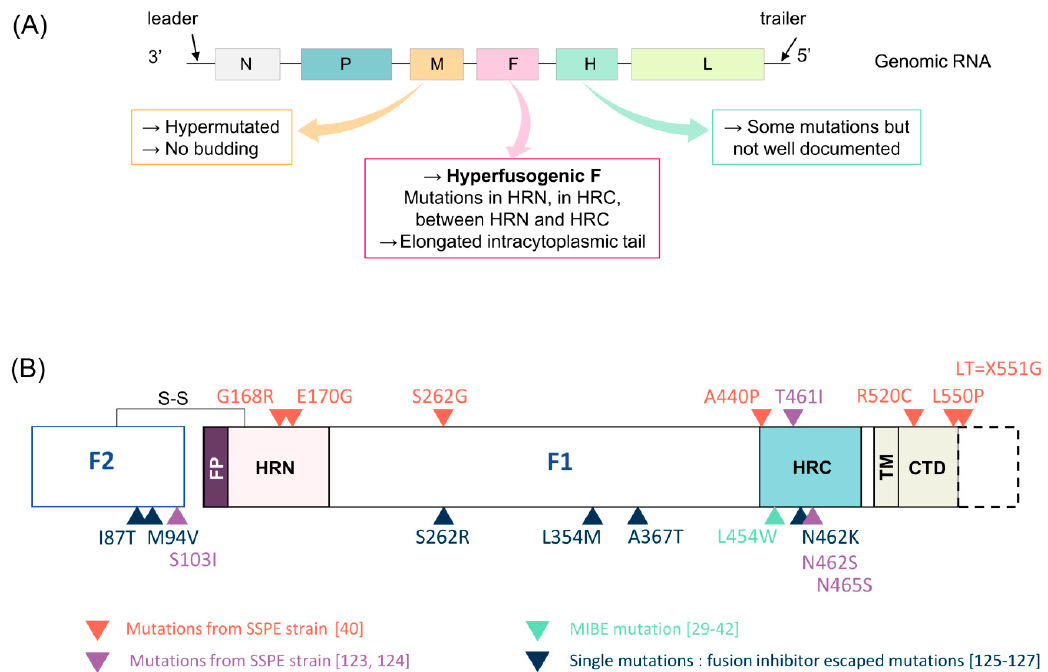
Figure 3. MeV F gene mutations related to CNS infection. ( A ) Schematic of MeV genome showing the most common mutations found in SSPE cases. ( B ) Details of MeV mutations in F protein leading to a hyperfusogenic phenotype and/or CNS